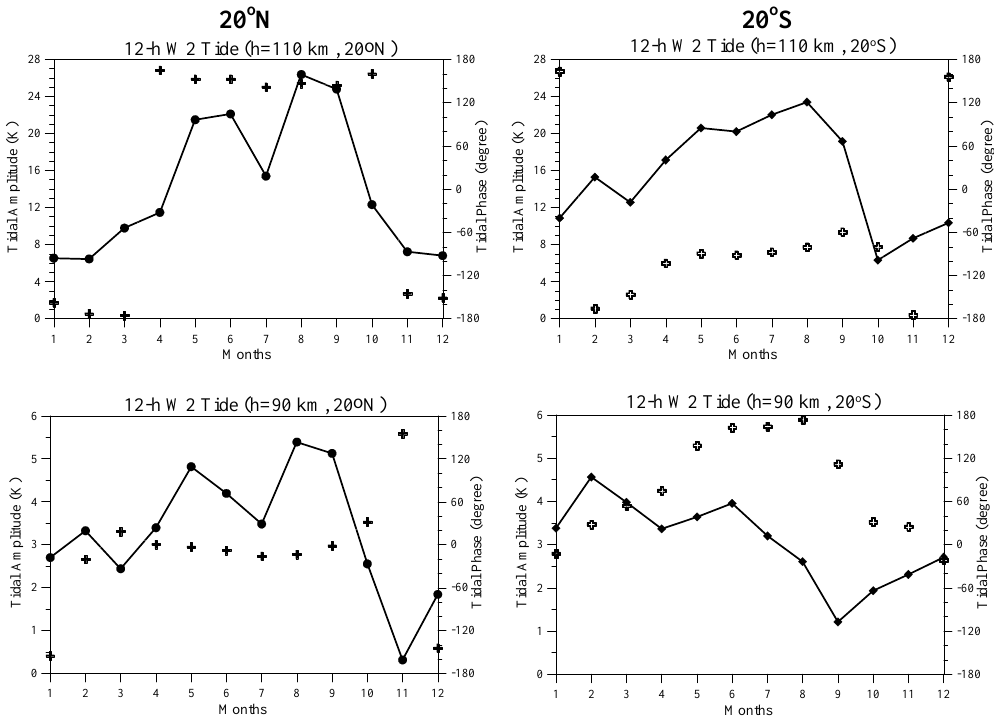
Figure 7 Fig. 7. Average (2002–2007) seasonal behavior of the tidal amplitudes (solid line with dots for 20 ◦ N and with diamonds for 20 ◦ S) and phases (crests for 20 ◦ N and empty crests for 20 ◦ S) at altitudes: 110km (upper row of plots) and 90km (bottom row); the results for the NH are shown in the left column of plots and for the SH – right column of plots.